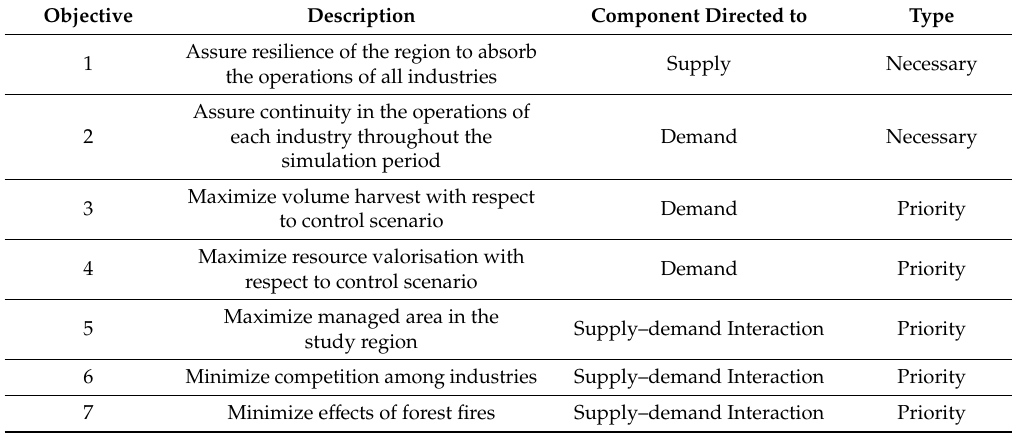
Figure 3. Protocol for the application of the AppTitude ® process / methodology. Table 1. Objectives established for the ranking and selection of solutions for the particular case of this research (Nordeste region,